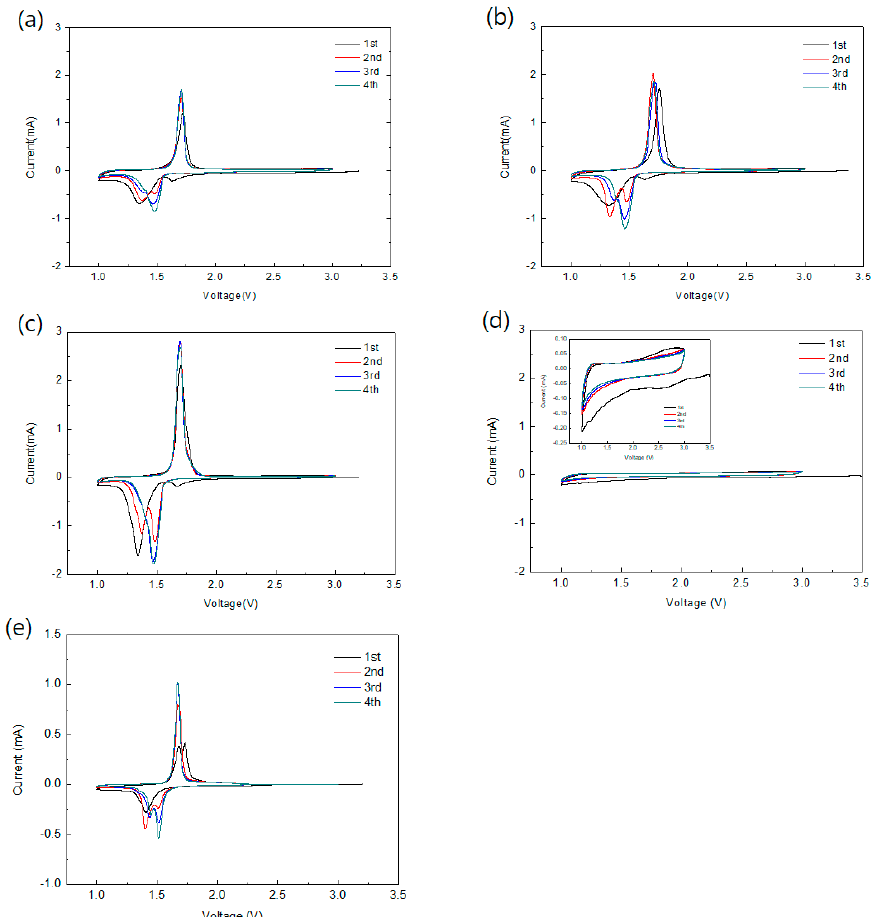
Figure 4. Cyclic voltammetry results for the ( a ) LC40 film, ( b ) LC50 film, ( c ) LC60 film ( d ) buckypaper, and ( e ) LTO_Cu electrode in the first through fourth cycles at 0.1 mV/s in a voltage window of 1–3 V (vs. Li + /Li).